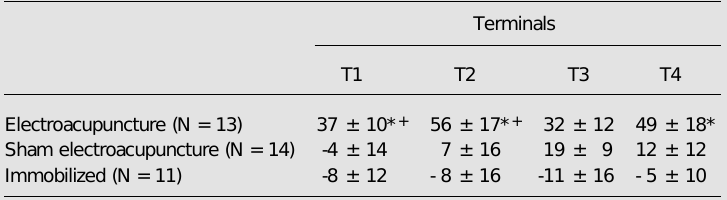
Figure 2. Electromyographic re- cordings from a group I animal (electroacupuncture) during baseline control recording prior to stimulation (A) and 10 min after electroacupuncture stimu- lation (B). Note the increase in the number and amplitude of the myoelectric motor complex in B compared to A . Calibration bars: 10 min and 100 mV.